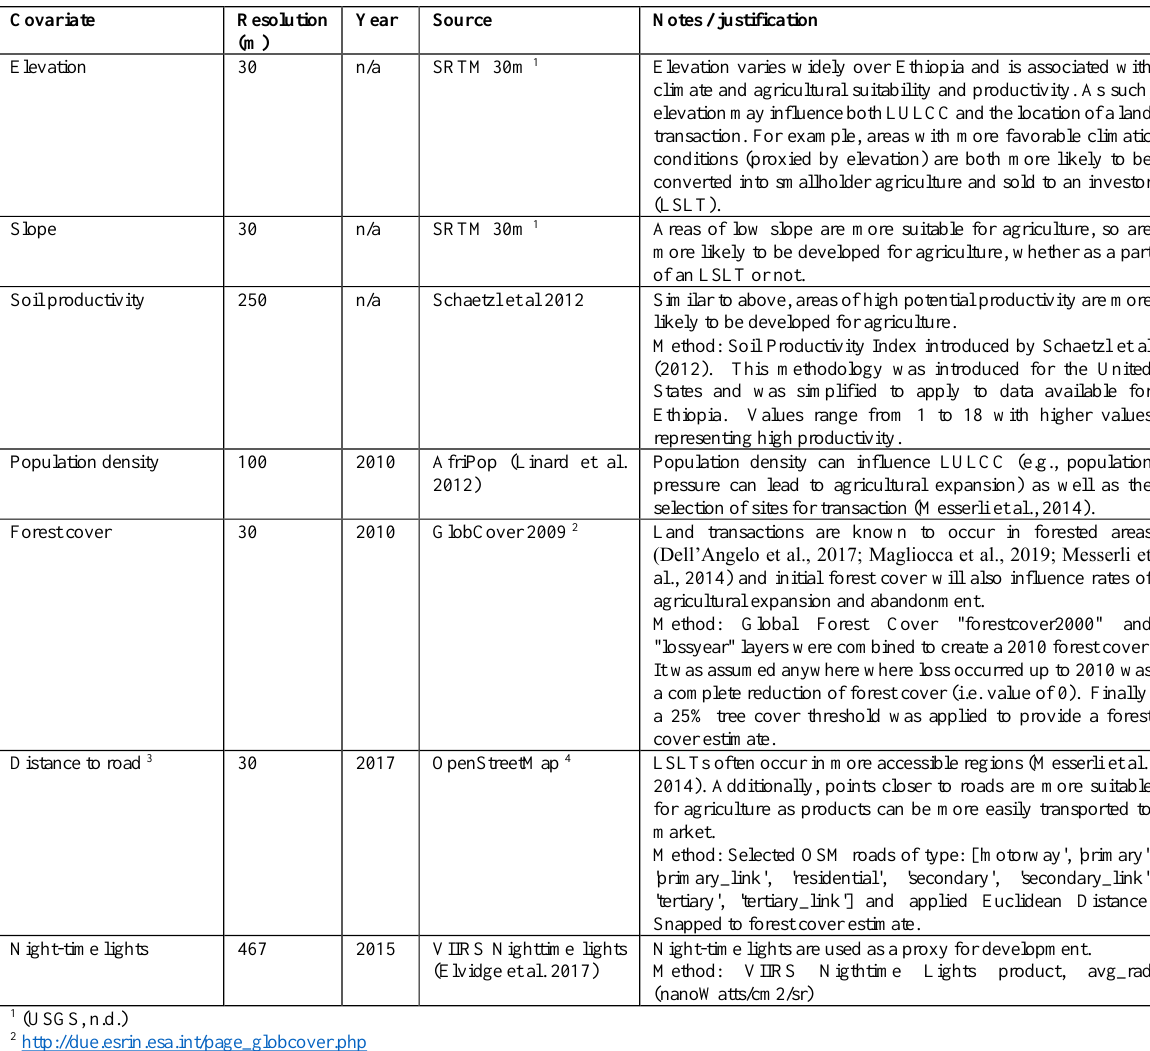
Table A3.1: Sources and brief justification for covariate data. Where possible, covariate information was drawn from data that pre-dated the implementation of the